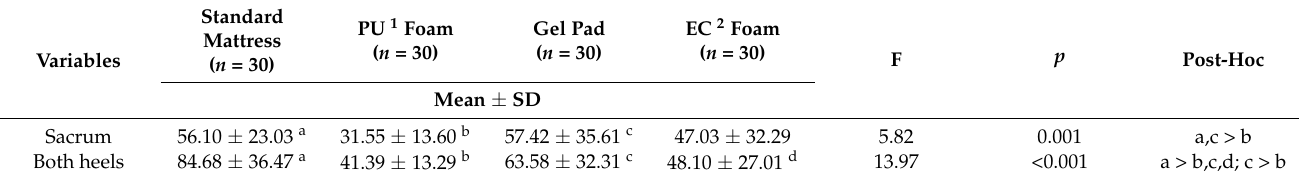
Table 2. Comparison of the average interface pressures of pressure-relieving overlays (mmHg).